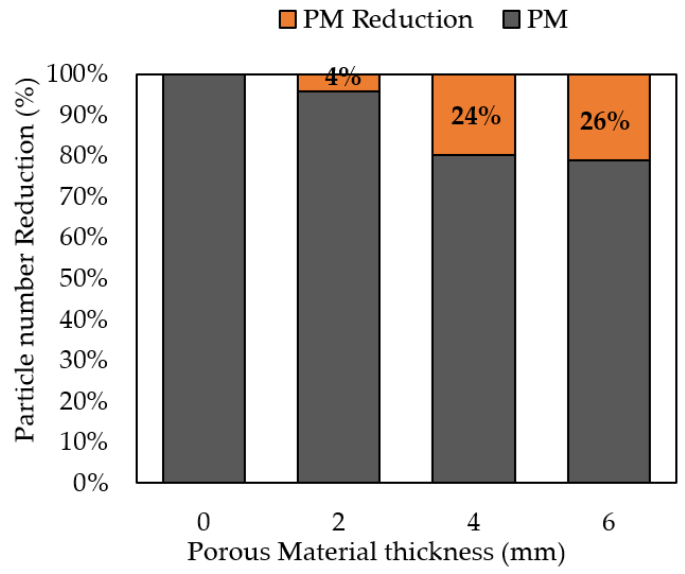
Figure 8. The reduction of Particle number with Porous Material and without NTP.